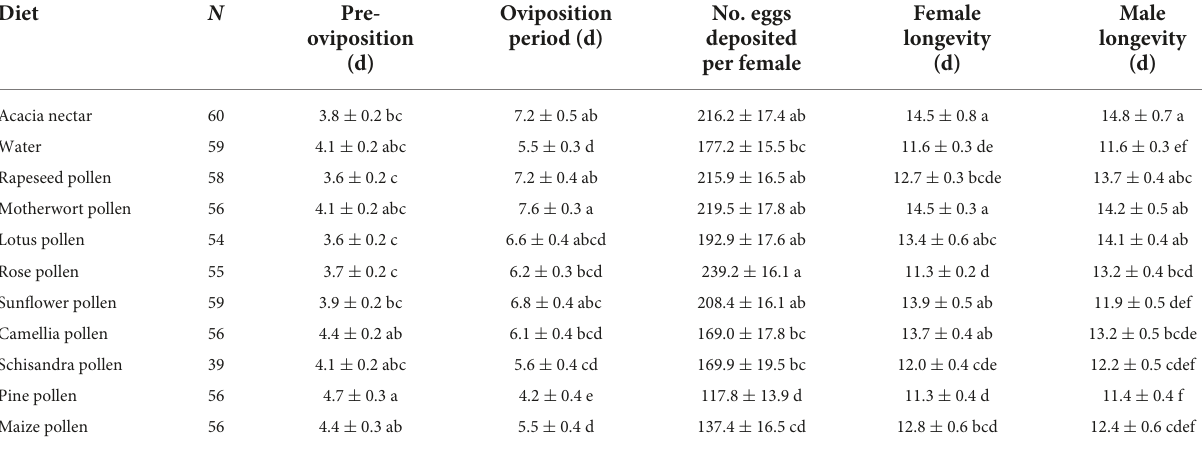
TABLE 4 Means ( ± SE) for longevity and fecundity variables for adults of Athetis lepigone on different diets.